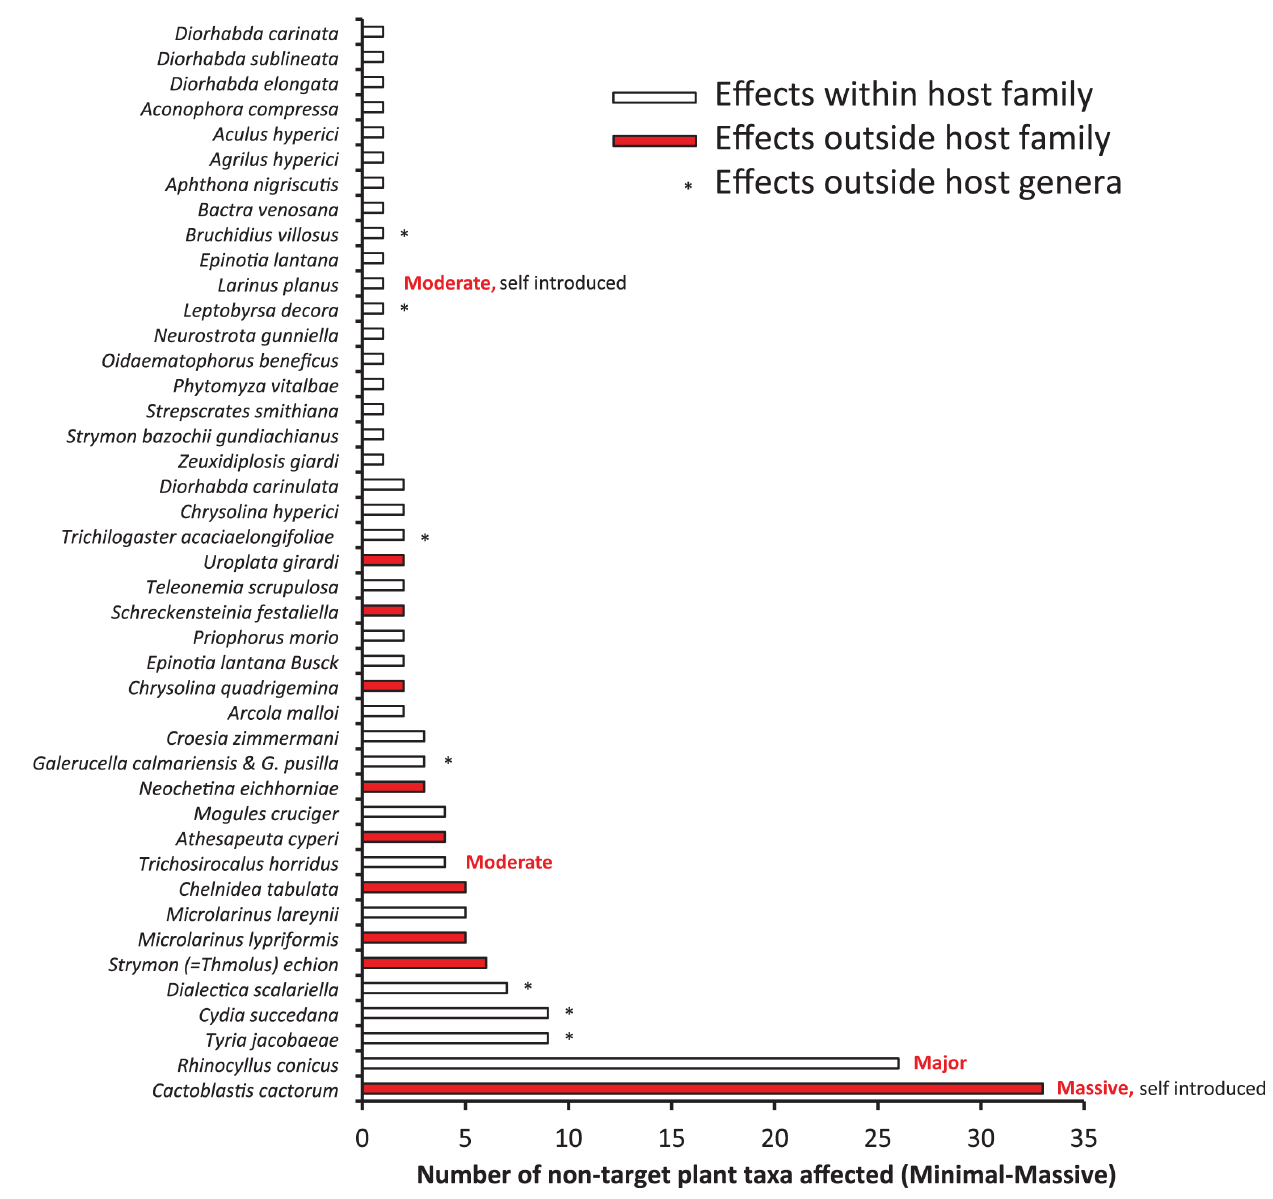
Figure 4. Number and phylogenetic proximity of non-target plant taxa known to be affected by weed biological control agents (minimal-massive).